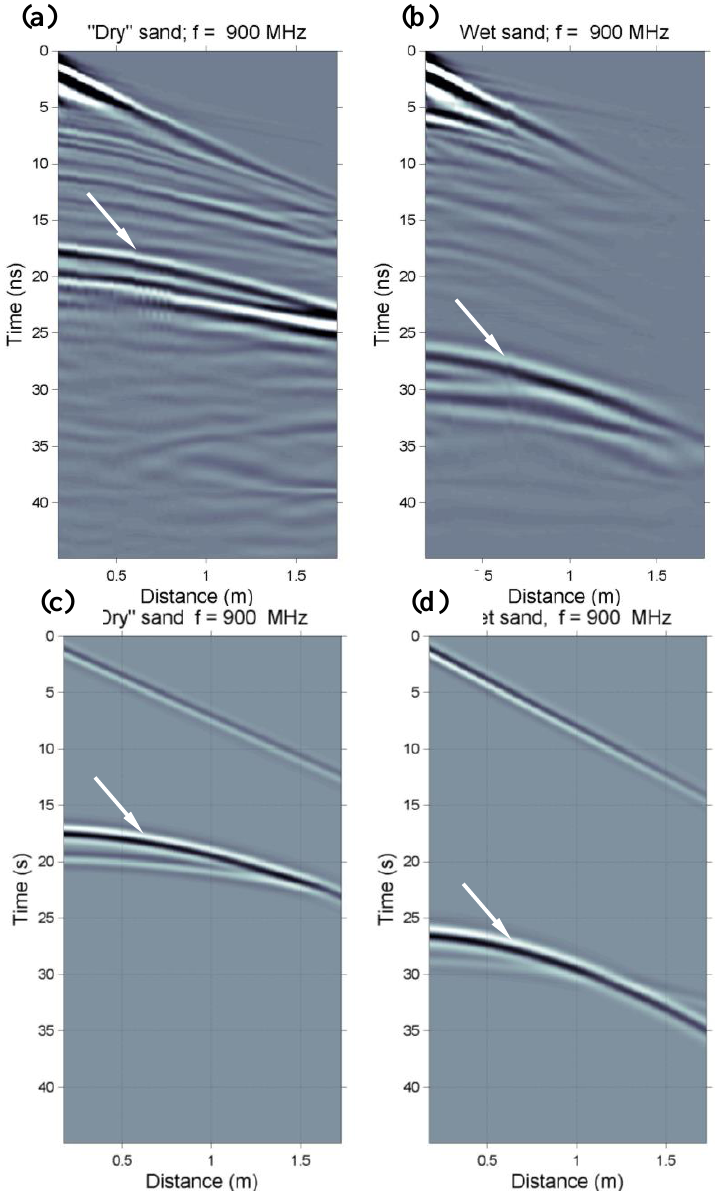
Figure 9. Two CMPs obtained with a 900 MHz antenna positioned in the middle of the common-offset profiles shown in Figure 8. ( a ) for dry sand and ( b ) for wet sand with the water table 48 cm below the surface of the sand. White arrows indicate the reflection from the bottom of the sandbox; ( c ) Modeling with V = 0.14 m/ns ( κ = 4.6) for the direct soil arrival and V = 0.116 m/ns ( κ = 6.7) for the reflection; ( d ) Modeling with V = 0.1195 m/ns ( κ = 6.3) for the direct soil arrival and V = 0.076 m/ns ( κ = 15) for the reflection (Author’s own work).